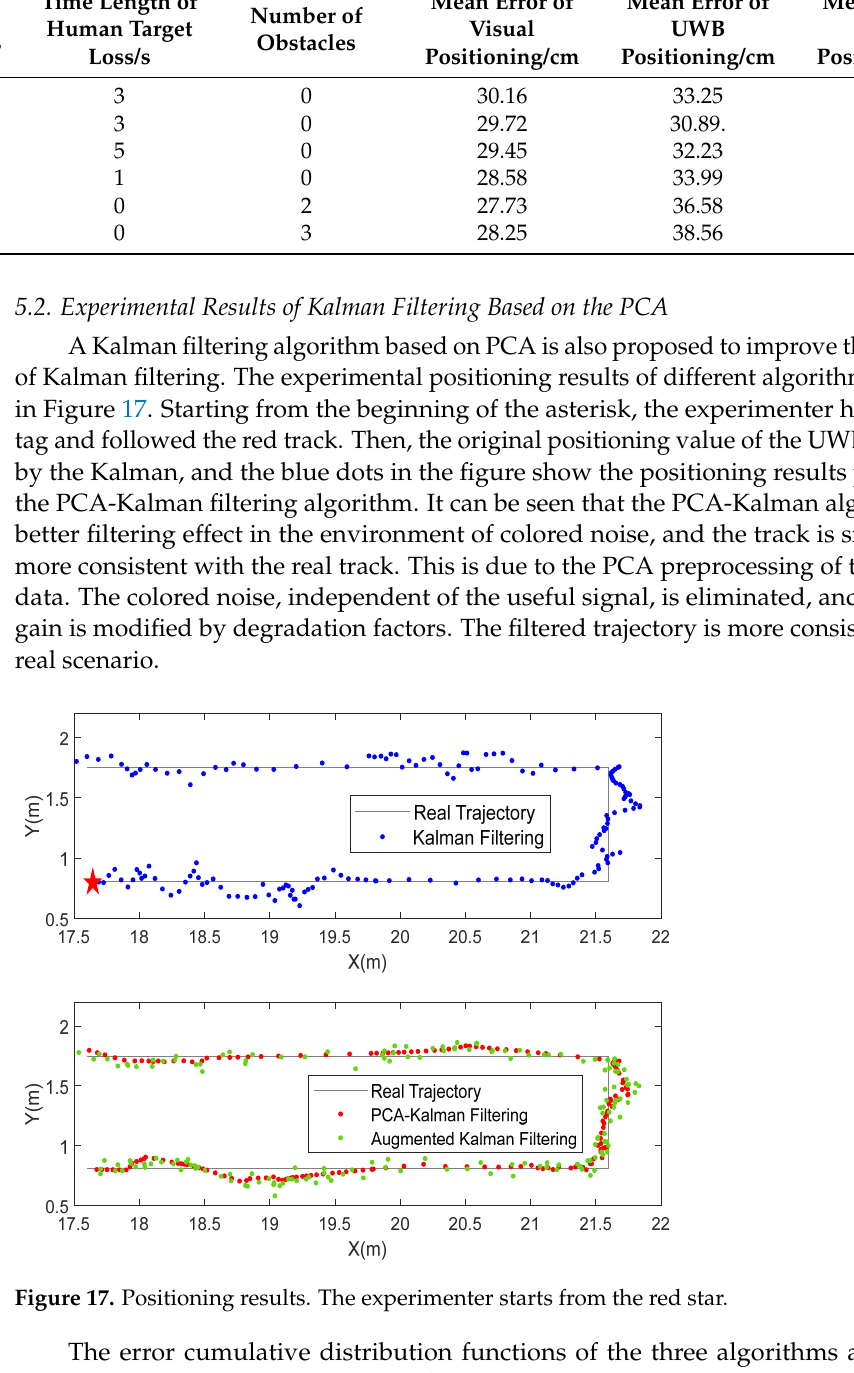
Figure 18. The positioning results of the proposed algorithm have an accuracy of